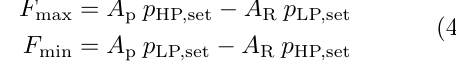
the piston side